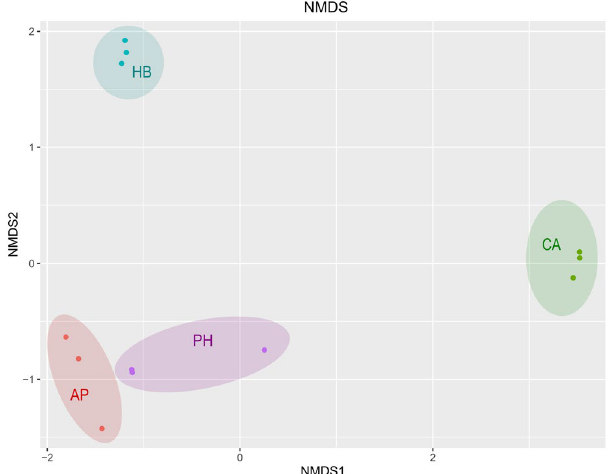
Figure 5. Non-metric multidimensional scaling (NMDS) plot for the enriched microbial populations (acetophenone AP ; trans -cinnamic acid CA ; p -hydroxybenzoic acid HB ; phenethyl alcohol PH ). Each biological replicate is represented by a